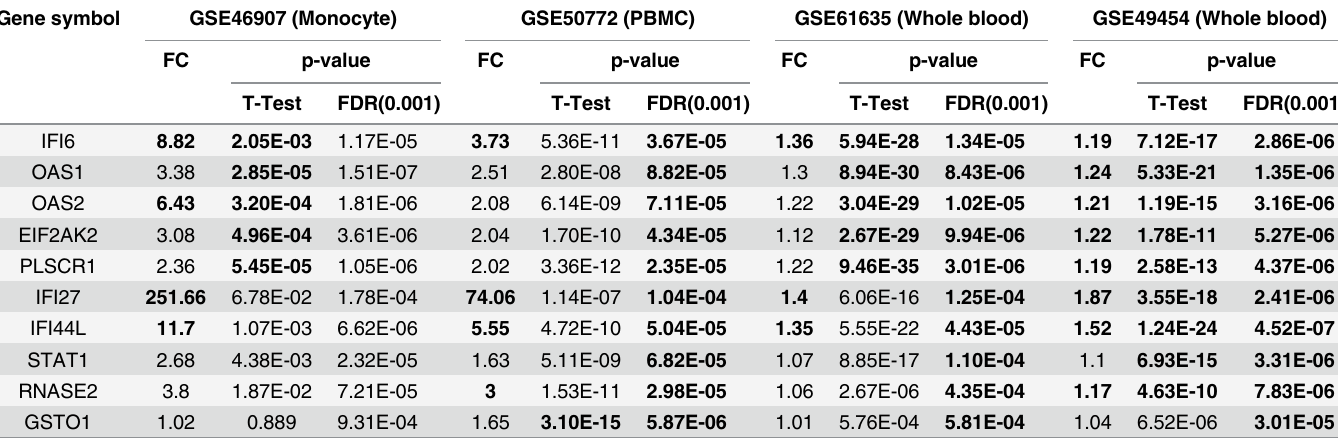
Table 2. Statistics (FC,T-test and FDR-adjusted p values) for the Ten Common Marker Genes in the Four Studied Datasets.